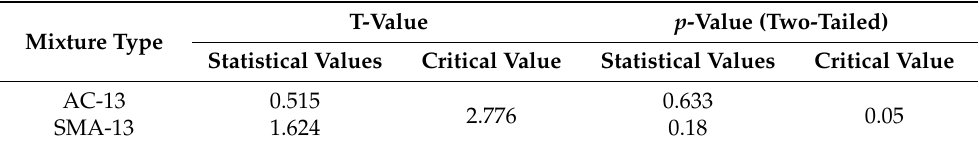
Table 9. T-test of BPN from 24,000 to 30,000 abrasive